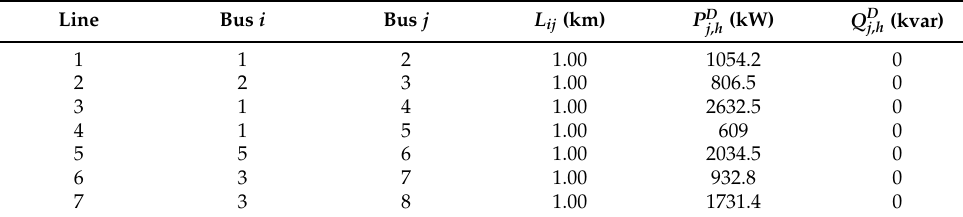
Table 4. Information corresponding to the 8-bus test system for the balanced case.